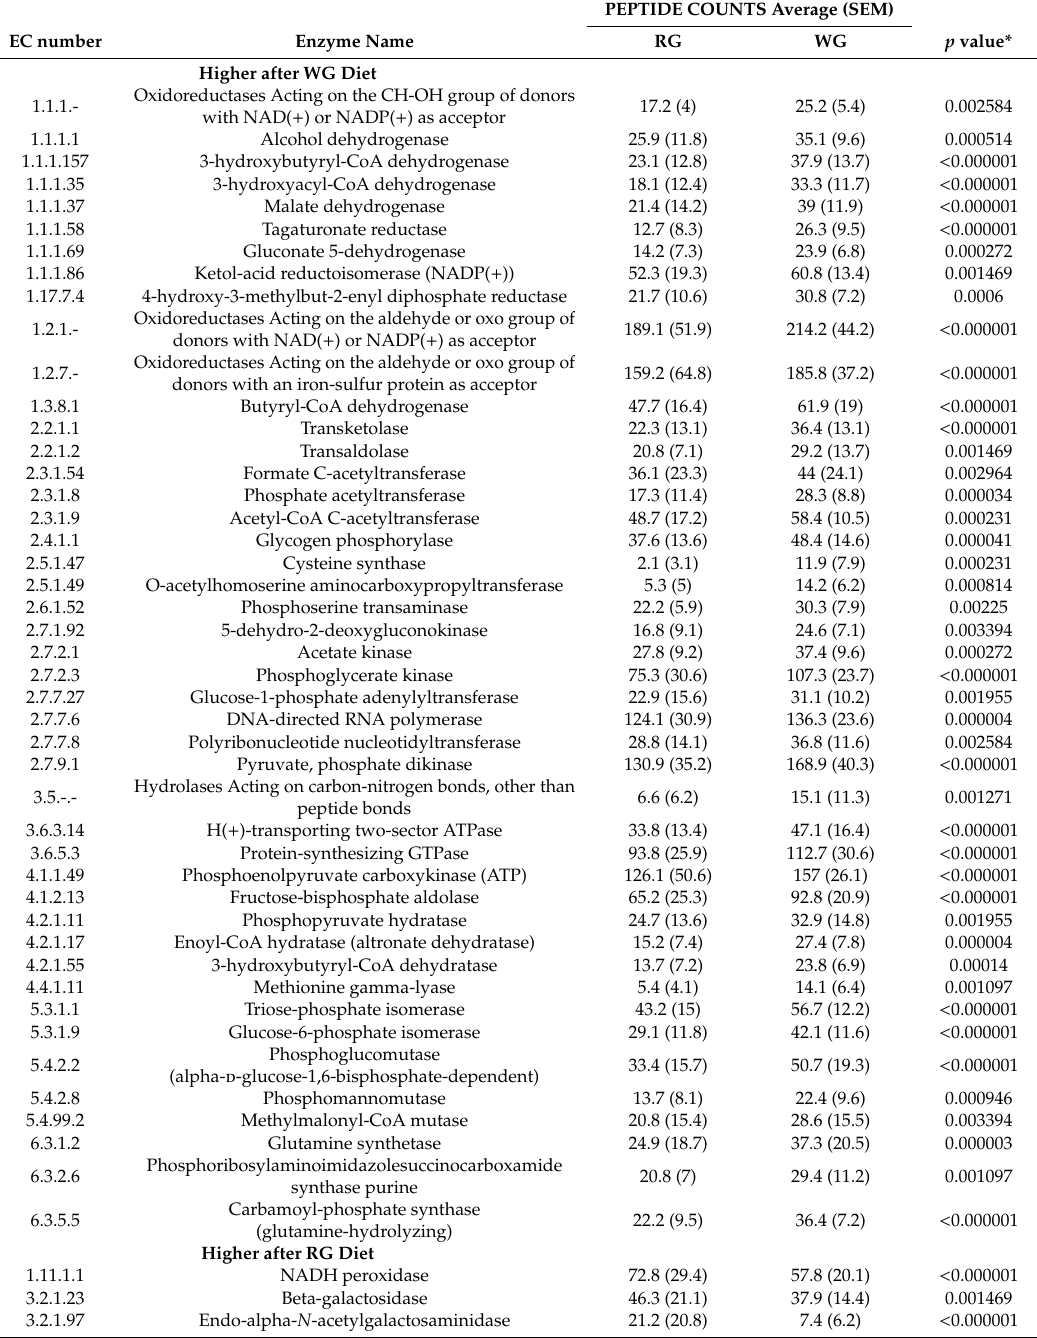
Table 1. Bacterial enzymes with significantly di ff erent abundance between the two